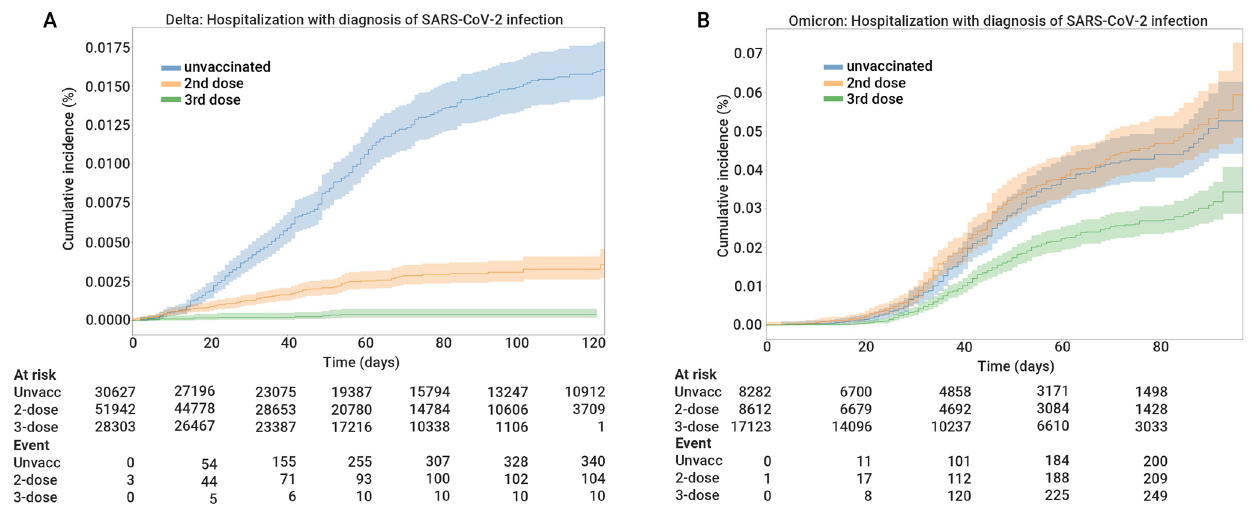
Fig. 3|Cumulativeincidenceofstudy outcomes,according toCOVID-19 waves and vaccination status. Cumulative incidence curves comparing the two study periods (Delta period on the left ( A ) and Omicron period on the right ( B )) for hospitalizations with a diagnosis of SARS-CoV-2 infection in pregnant women, by vaccination status (Third vaccine-green line, second vaccine-orange line, and